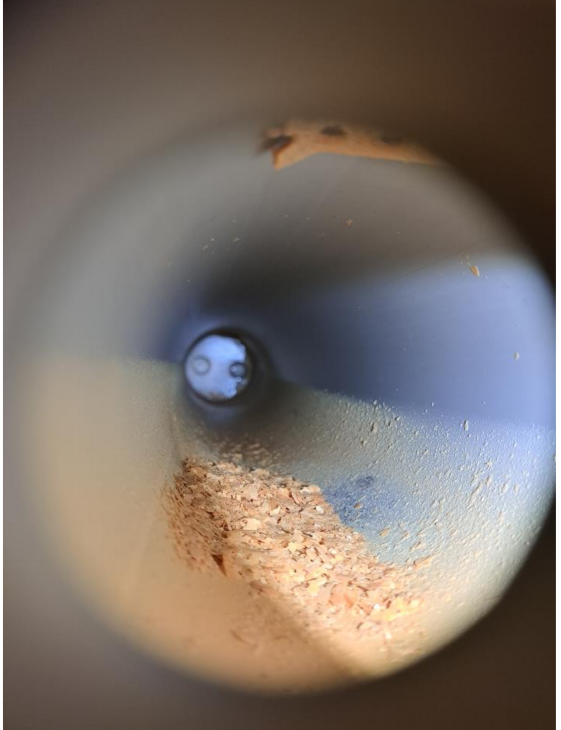
Figure 12. Inside of the UV lamp housing with accumulated fragments of incrustations.